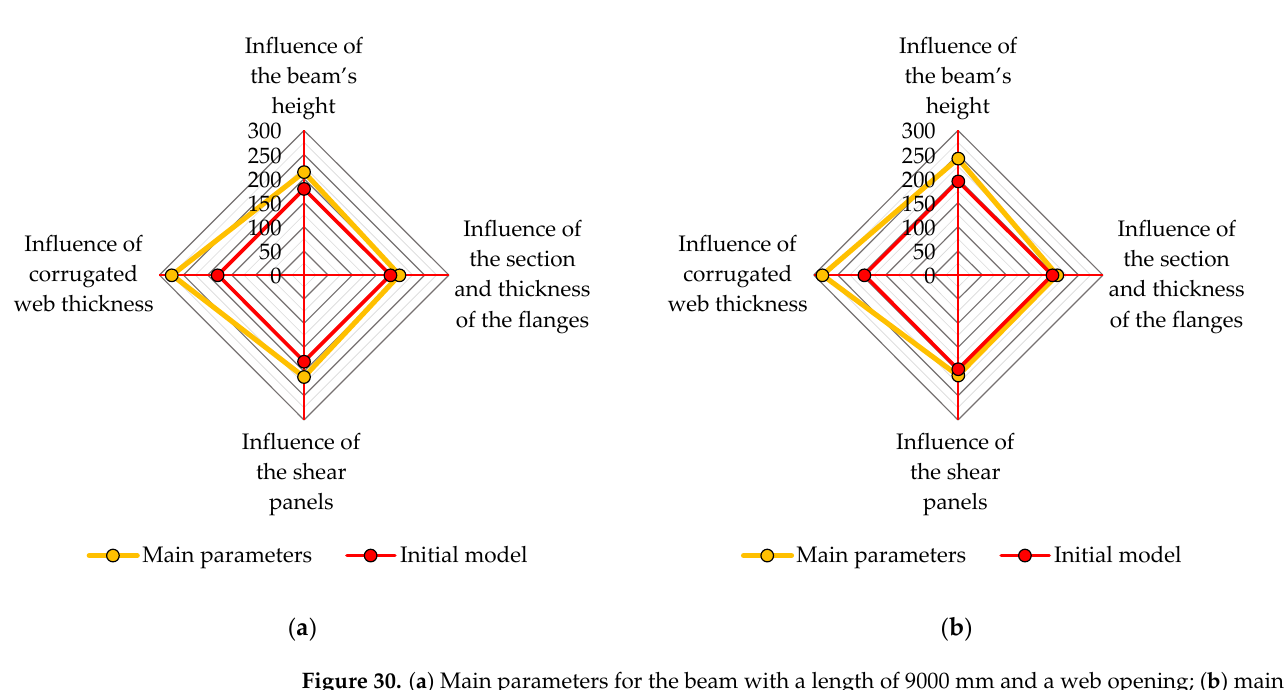
Figure 29. ( a ) Main parameters for the beam with a length of 7500 mm and a web opening; ( b ) main parameters for the beam with a length of 7500 mm without a web opening.